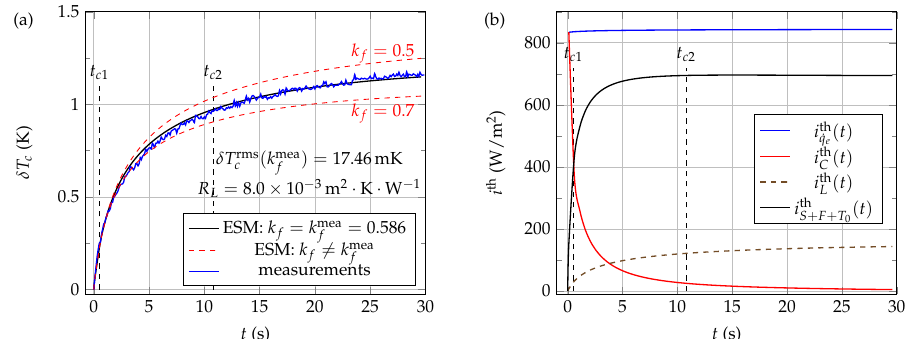
Figure 18. Experimental and 1D ESM computed thermal signals in the case of pure water at rest. These signals were obtained using a voltage step excitation v 0 = 8.46V at a working temperature T 0 = 24.0 ◦ C and immersion length L i = 0.0mm: ( a ) measurements and electro-thermal systemic modeling results; ( b ) computed thermal current densities when the fluid thermal conductivity k f is = 0.586 in the ESM model. Thermal conductivities k set to the value k mea f The red dashed curves shown in Figure 18a illustrate the δ T rms